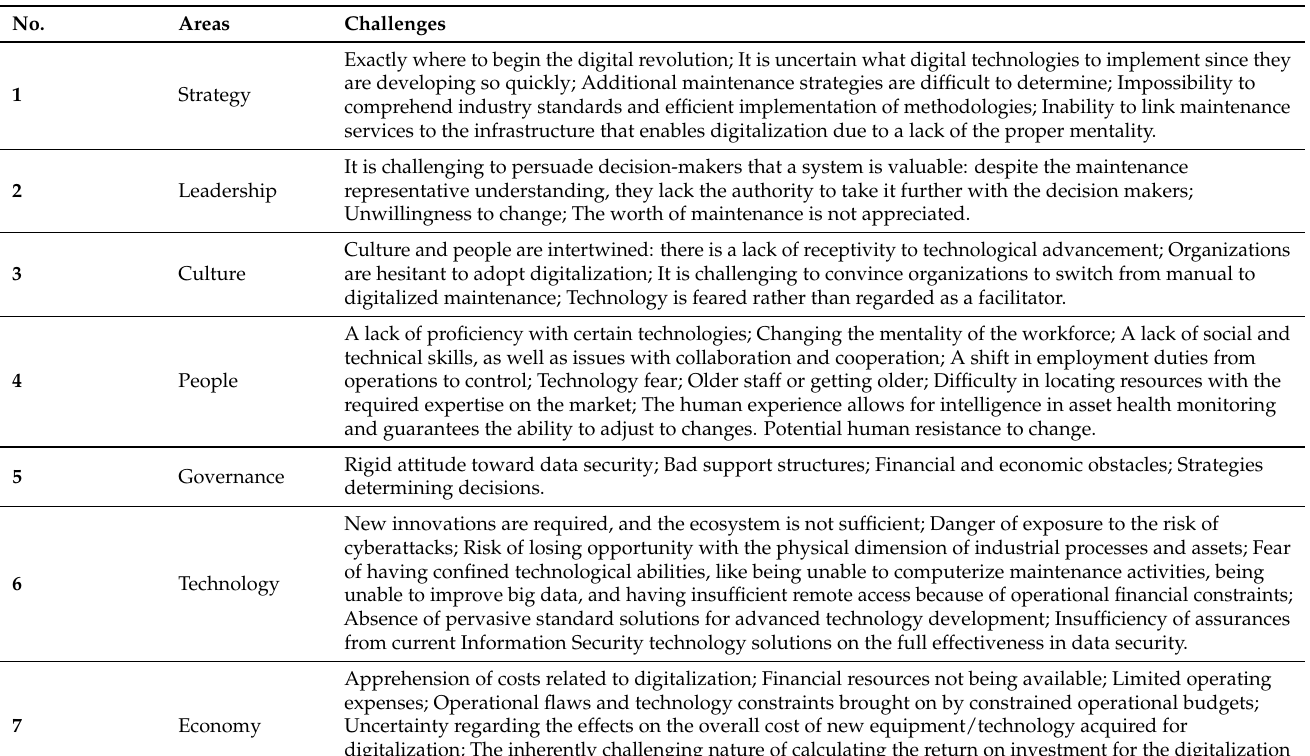
Table 2. Challenges of digitalization in maintenance management